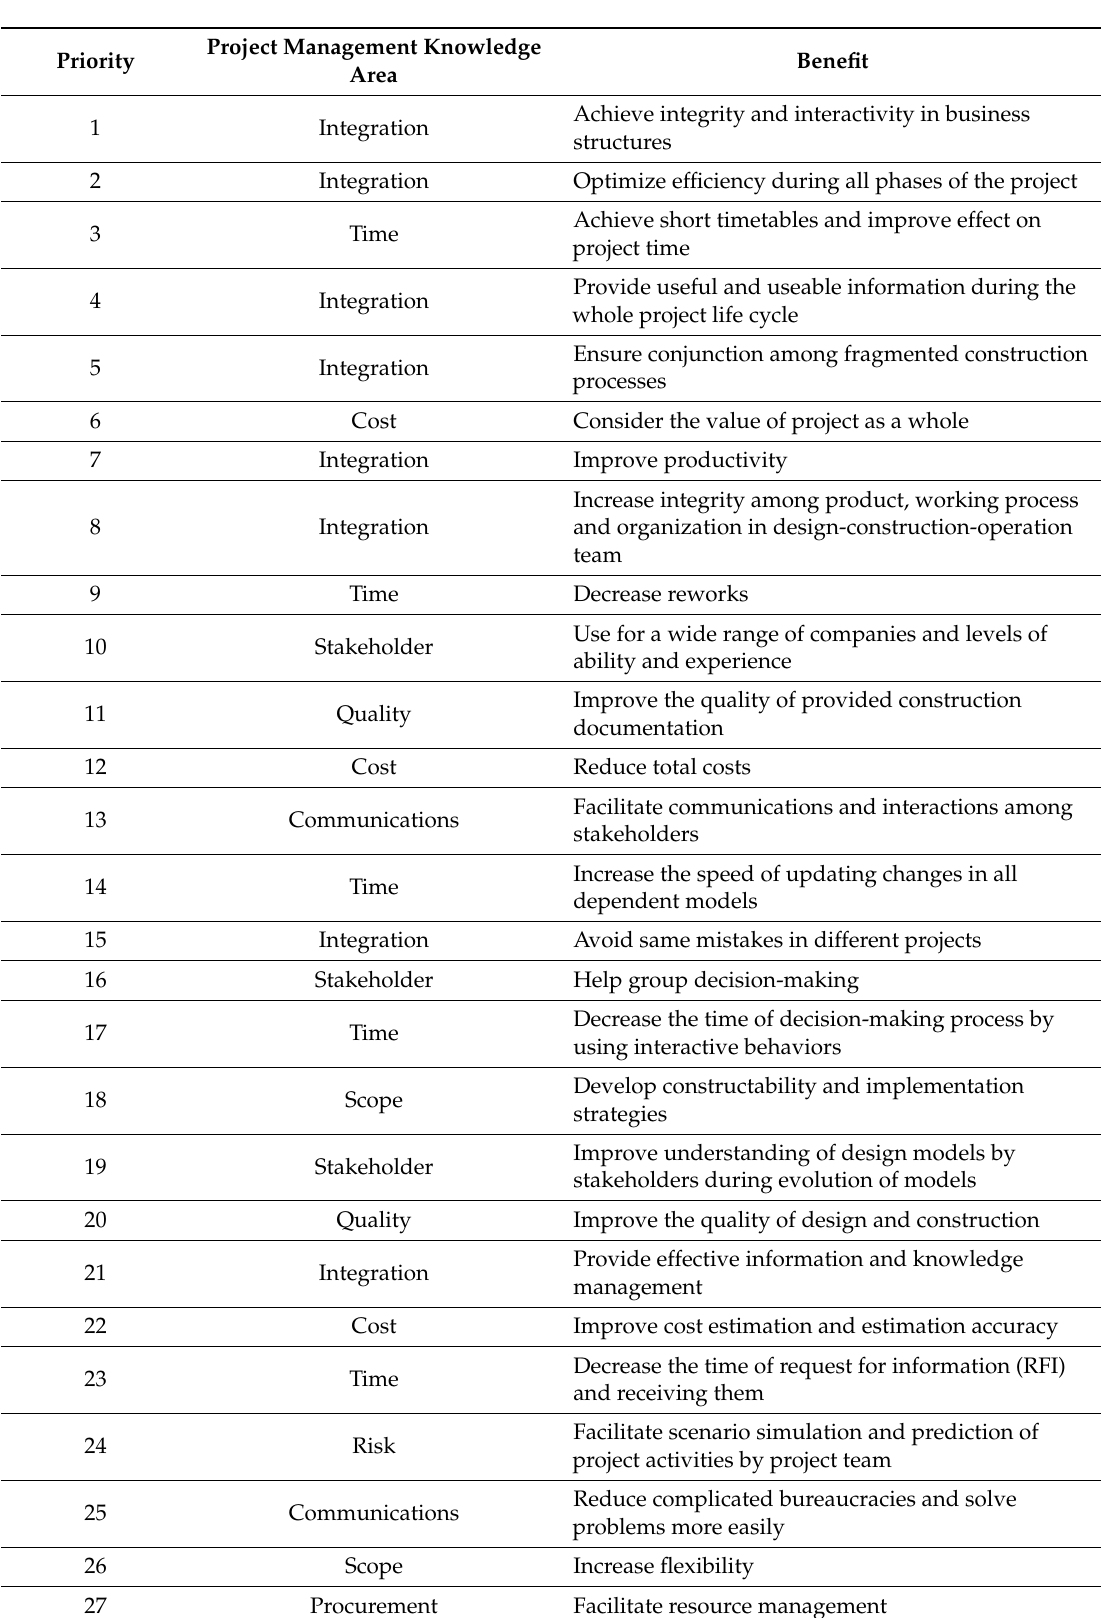
Table 12. Ranks of benefits of VIM